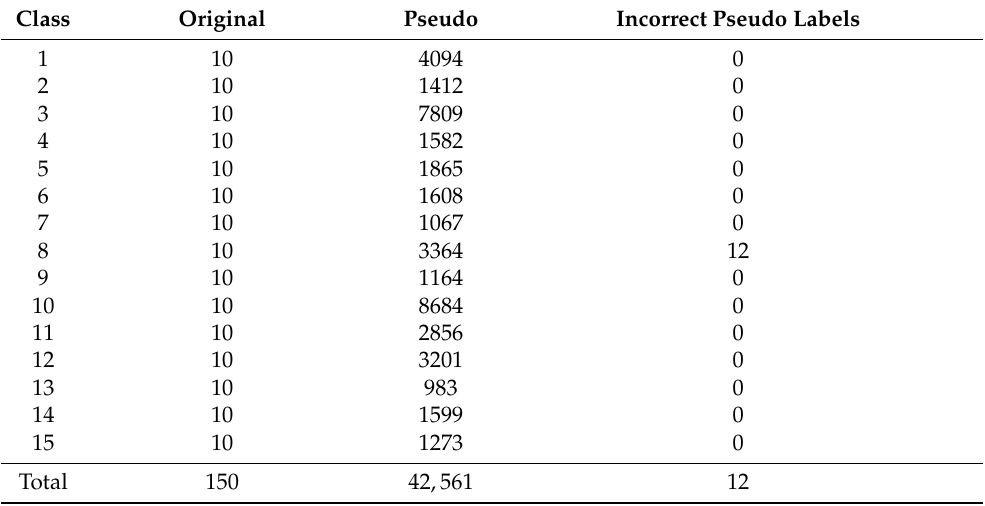
Table 5. Number of original samples, pseudo-label samples, and incorrect pseudo-label samples of each class for the Houston dataset.